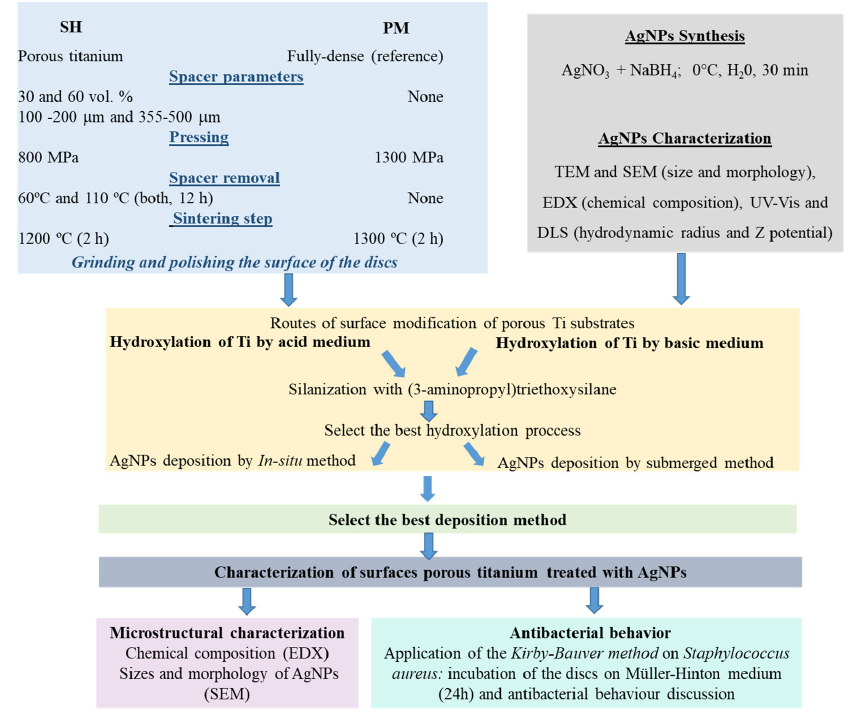
Figure 1. Scheme of the workflow of the study conducted in this investigation.